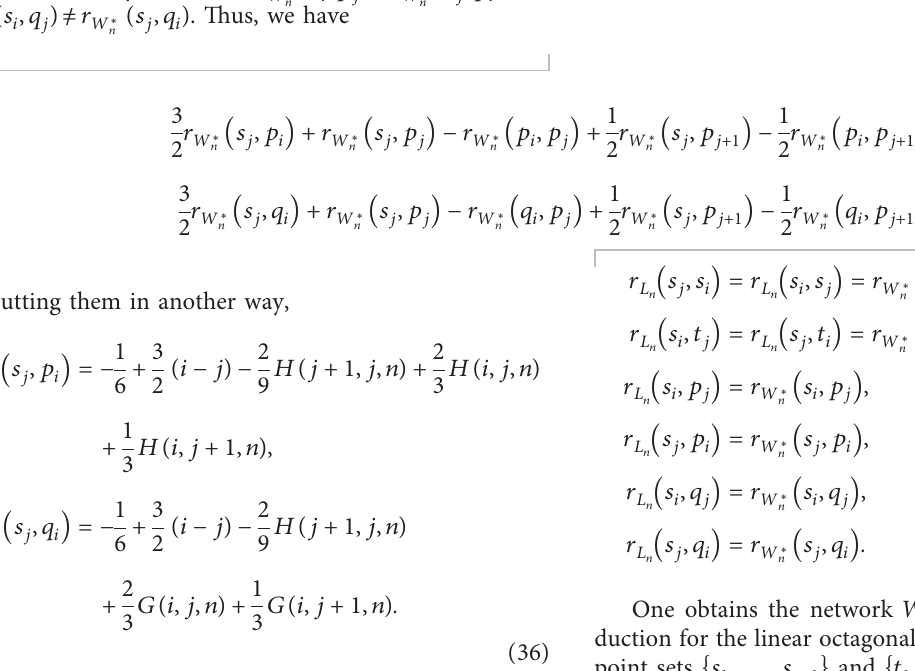
Figure 7: The network W ∗